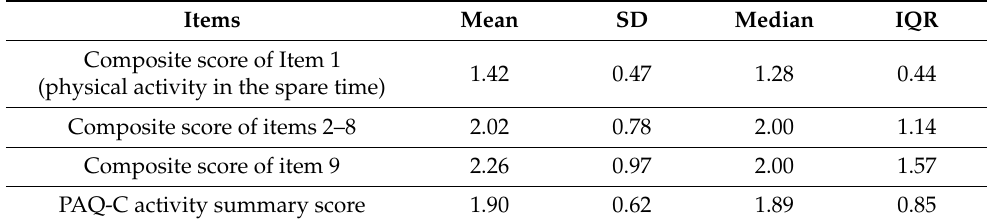
Table 3. Physical activity questionnaire scores